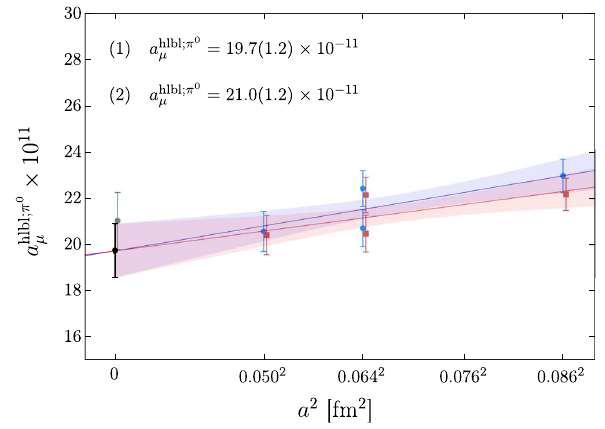
Fig. 6 The pion-pole contribution to a hlbl μ at the SU(3) f symmetric point with a pion mass of 420 MeV. Blue and red points correspond to two different discretizations of the 3-pt correlation function. The results (1) and (2) are explained in the main